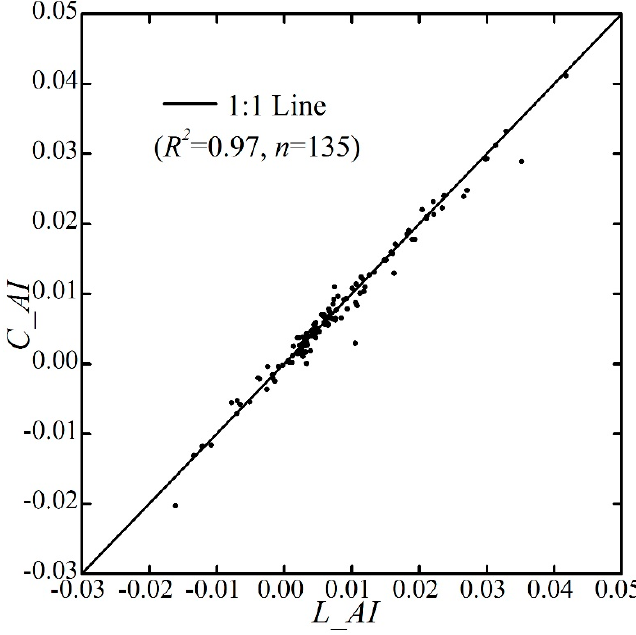
Figure 5. Comparison between the calculated annual aridity index trend ( C_AI ) and the detected aridity index trend by linear regression ( L_AI ) for the 135 meteorological stations in Southwest China from 1993 to 2015.